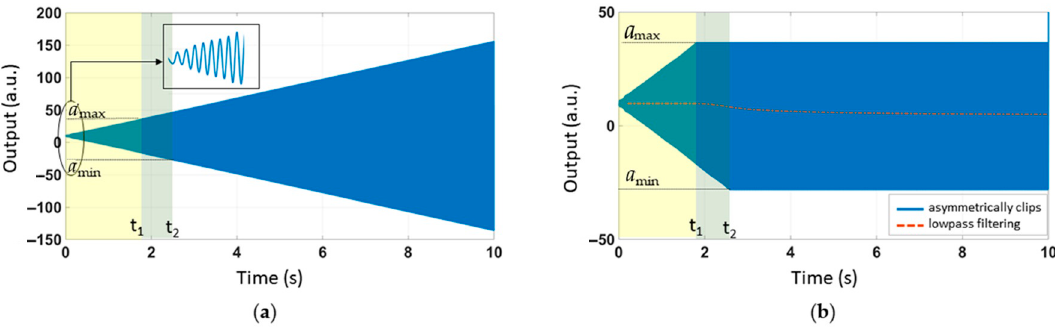
Figure 5. ( a ) The time-domain response of linear amplitude sweeping. ( b ) Bilateral asymmetric clipping and low-pass filtering.